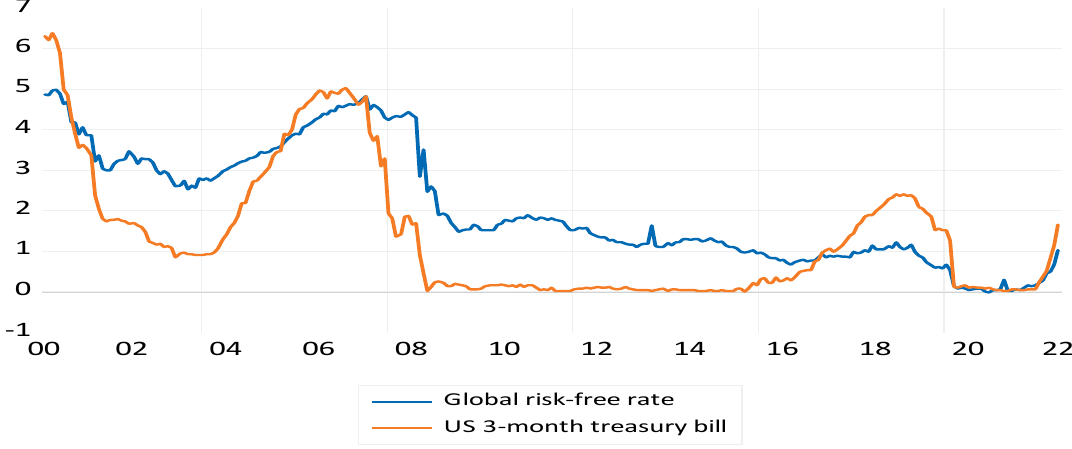
Figure 1. Global risk-free rate and US 3-TB.